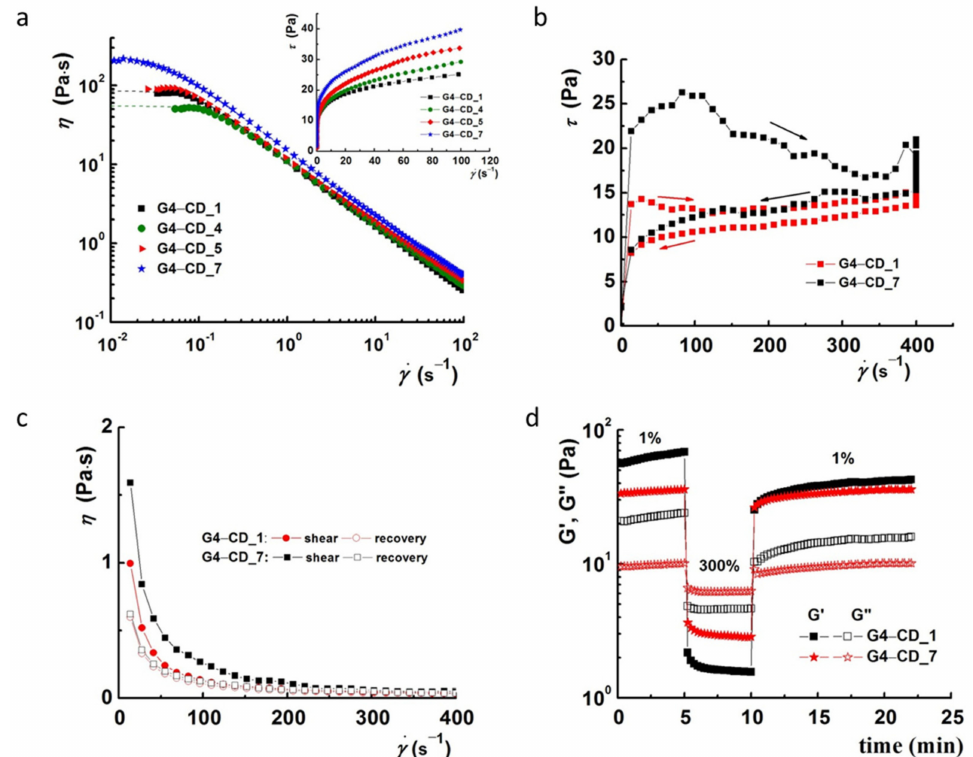
. Figure 7. ( a ) Apparent viscosity, η , versus shear rate, γ . The inset represents the variation of τ as a function of investigated samples; ( b ) hysteresis loops for G4–CD_1 and G4–CD_7 samples; ( c ) viscosity recovery at an increase of up to . γ ; ( d ) structure recovery ability determined by the continuous step strain measurements 400 s − 1 and a decrease to 0 from (1%–300%–1%) of G4–CD_1 and G4–CD_7 samples at ω = 10 rad s − 1